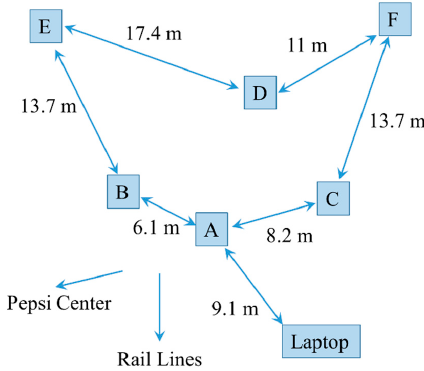
Figure 4. Distribution of devices during outdoor experiments.